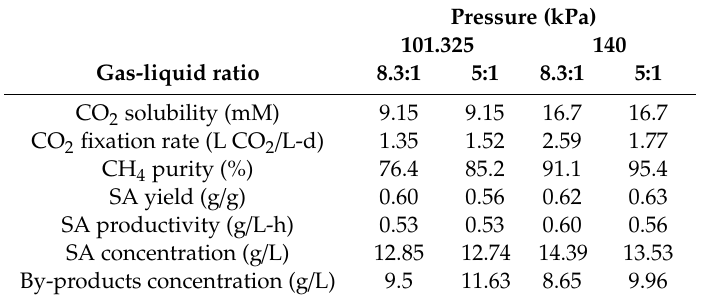
Table 4. Performance of the system at di ff erent pressure and gas–liquid